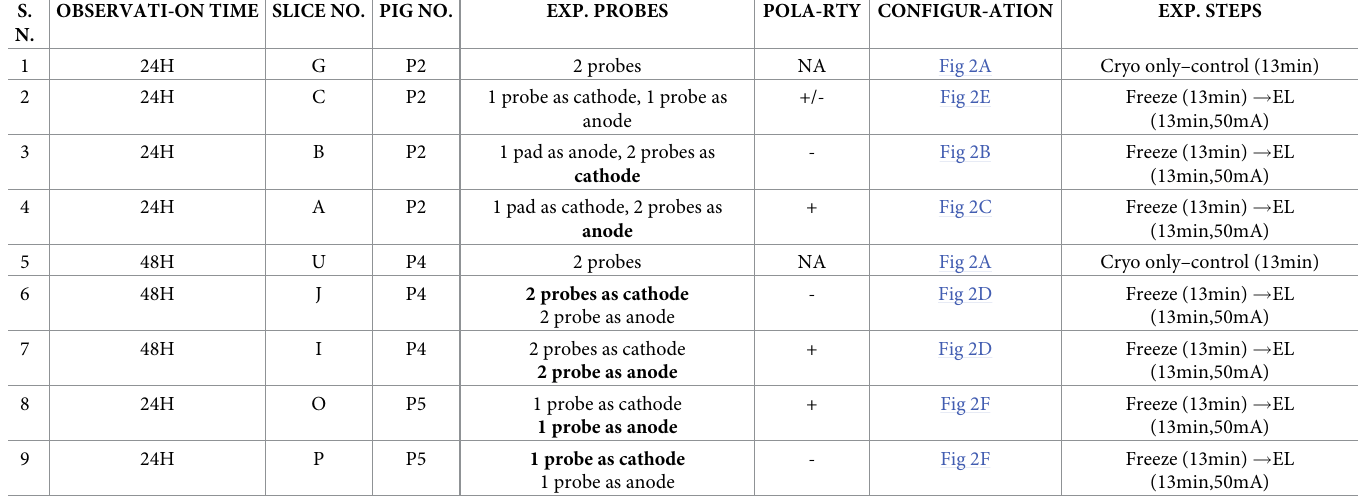
Table 1. Table of experiments.